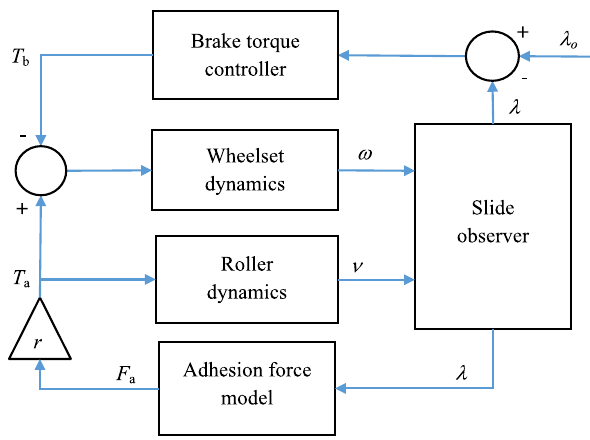
Fig. 12 Schematic diagram of the wagon model with